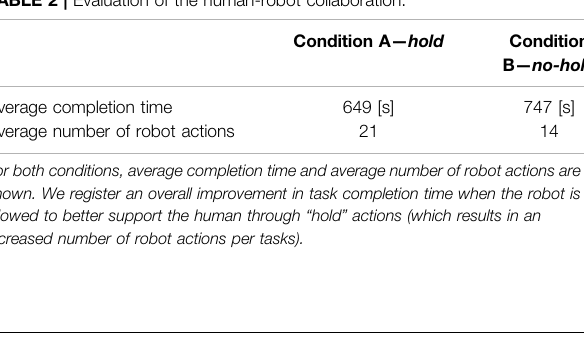
TABLE3| Examplehistoriesofactionsandobservationsduringtheinteraction,for the two